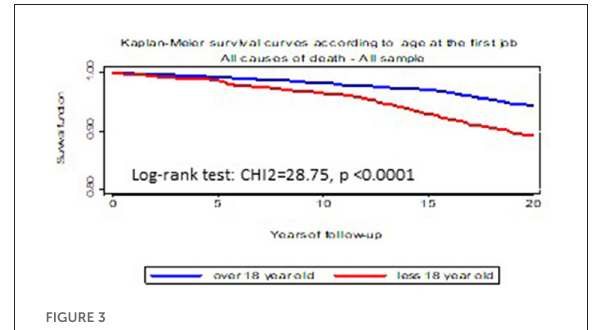
FIGURE3 Kaplan–Meier survival curves according to age at first job.